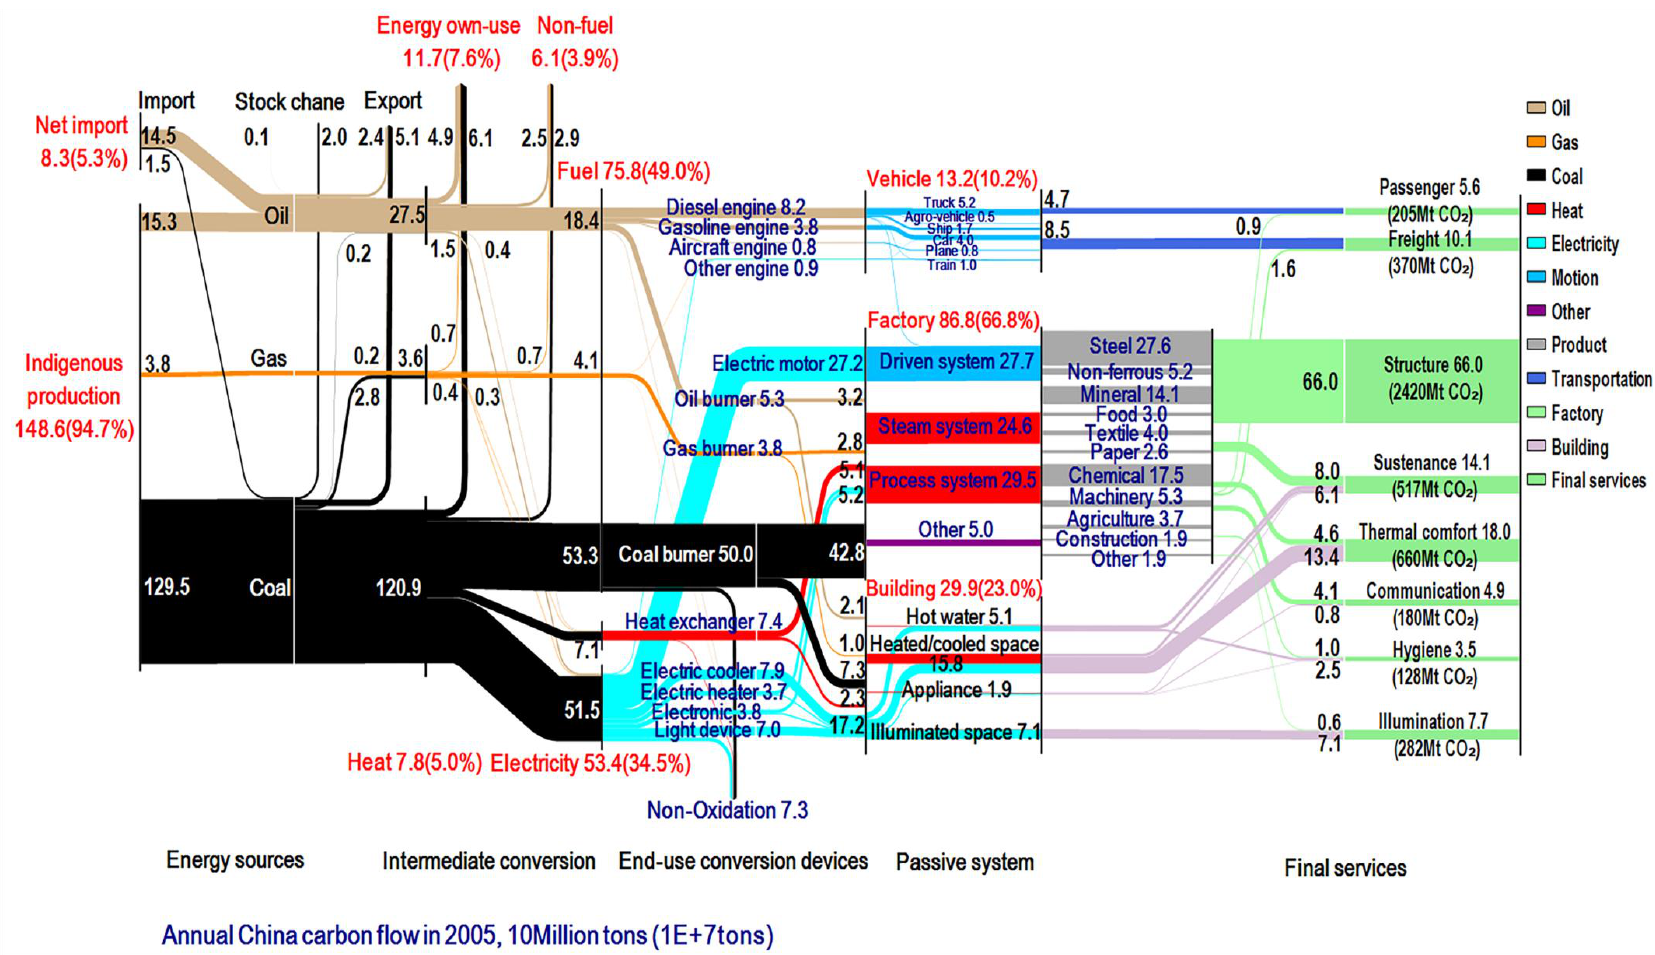
Figure 3. China’s energy-related carbon flow diagram in 2005, unit in 10 Mt C (10 7 tons C).